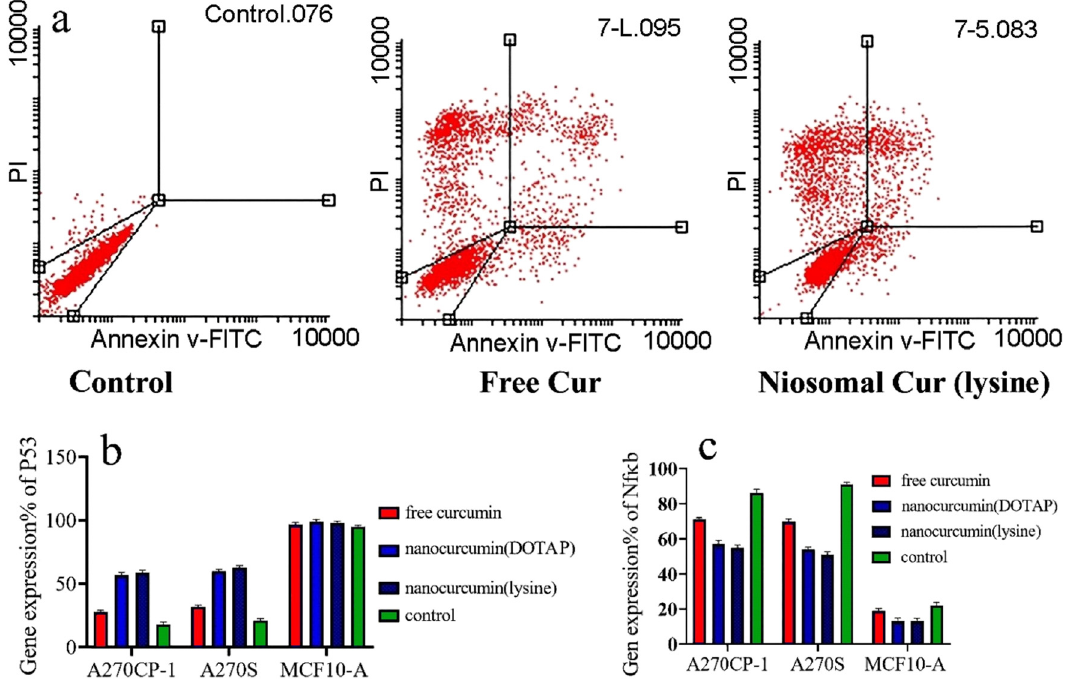
Figure 10: ( a ) Apoptosis assay by fl ow cytometry, after treating the cells for 48 h. ( b and c ) Real - time PCR quantitative analysis of p53 and Nf - ĸ B expression after the treatment with di ff erent formulations for 48